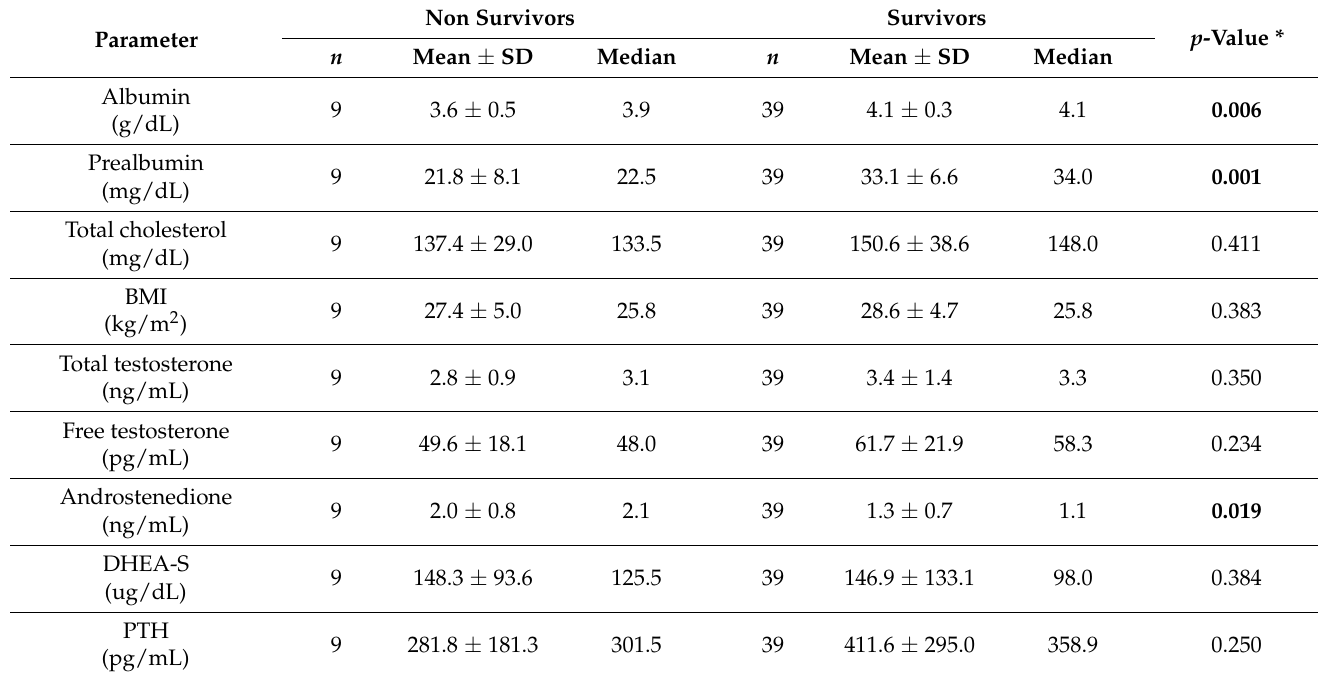
Table 4. Comparison between the group of men who died and the rest of male dialysis patients by selected nutritional parameters and the concentration of hormones in the blood serum.